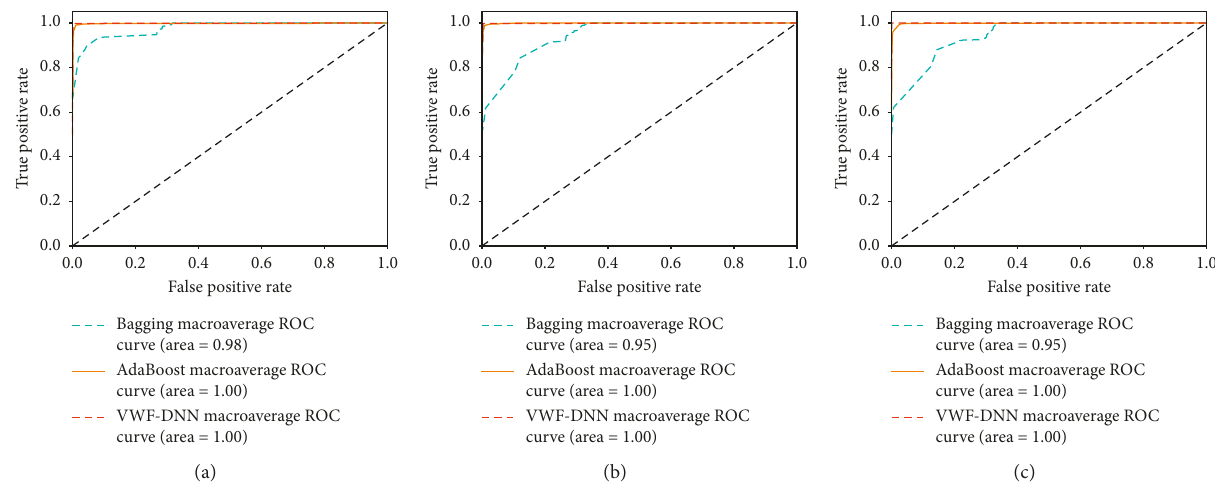
Figure 13: ROC curves of three classifiers at three paces: 0.78m/s (a), 1.0m/s (b), and 1.25m/s (c).